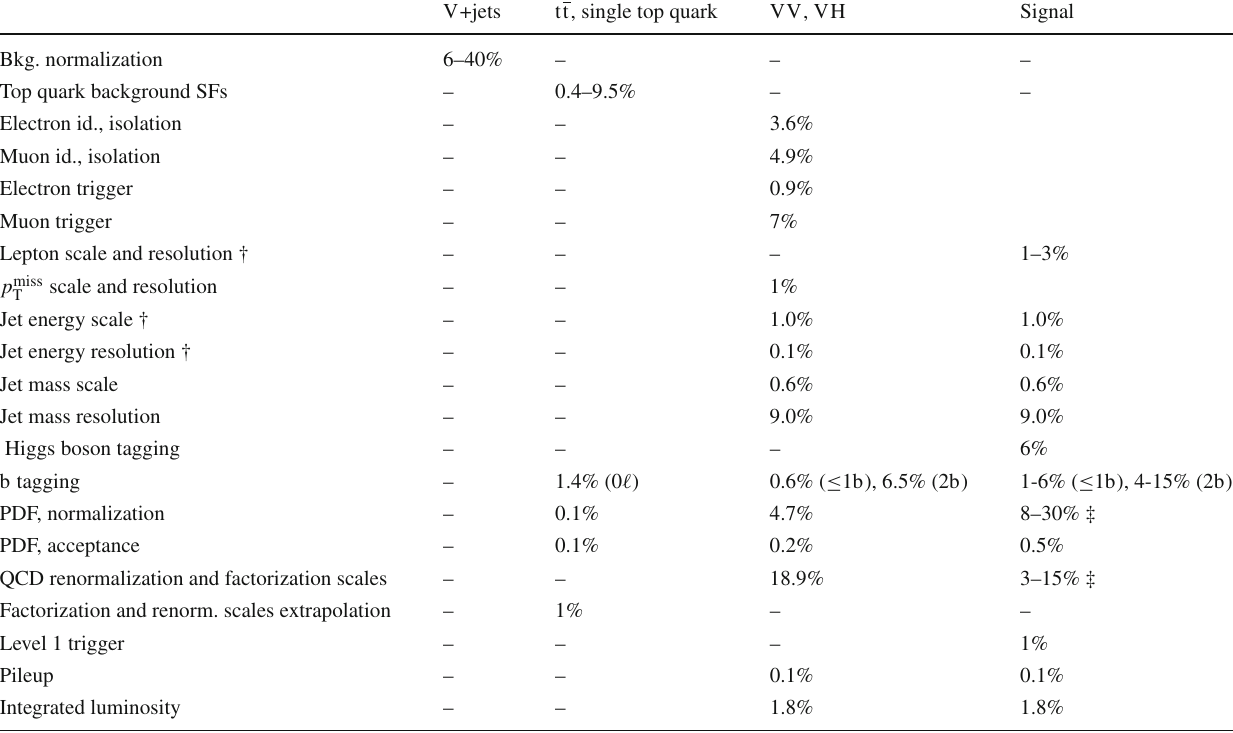
Table 4 Summary of systematic uncertainties for the background and signal samples. The entries labeled with † are also propagated to the shapes of the distributions. Uncertainties marked with ‡ impact the sig-